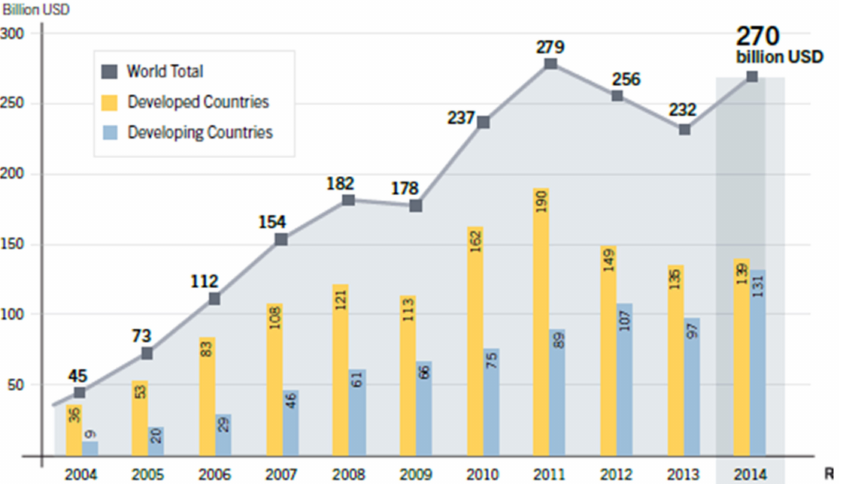
Figure 1. Global investment in renewable energies in billion dollars: period 2004–2014